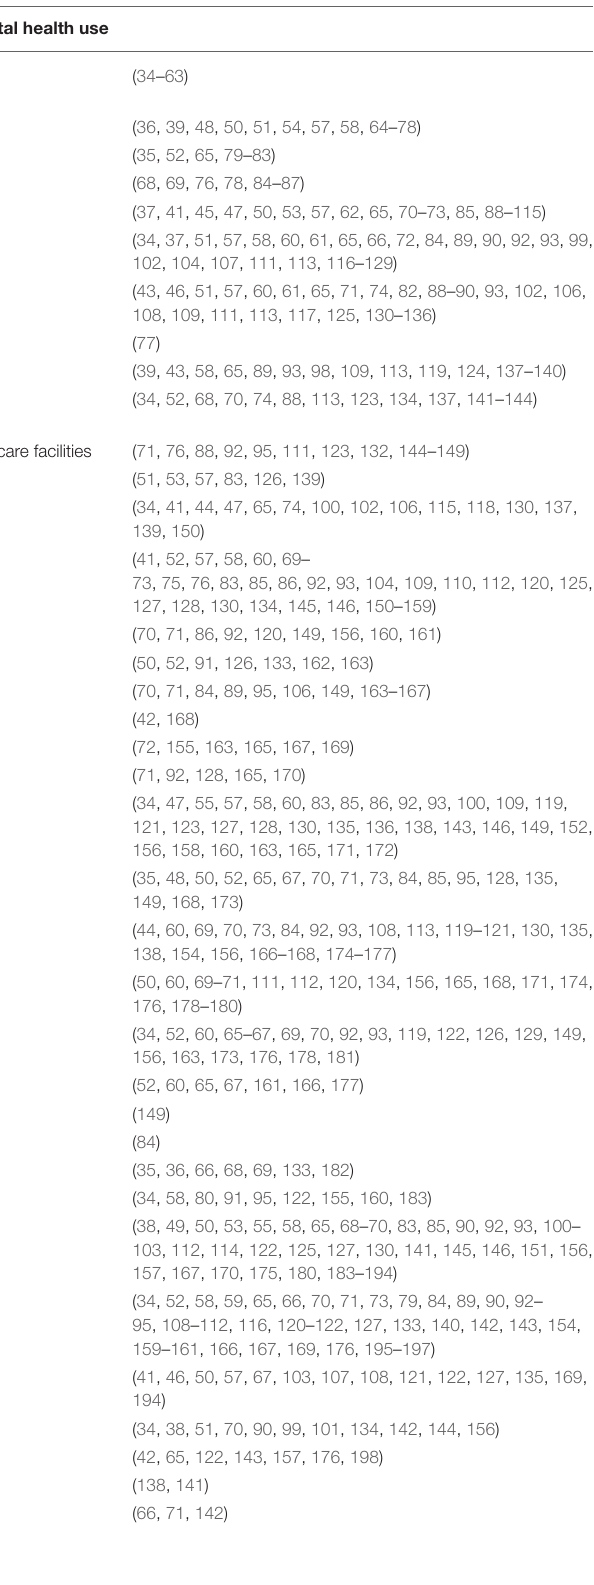
TABLE 1 | Telemental health usage classified by the NQF’s framework domains describing the objectives of included publications.